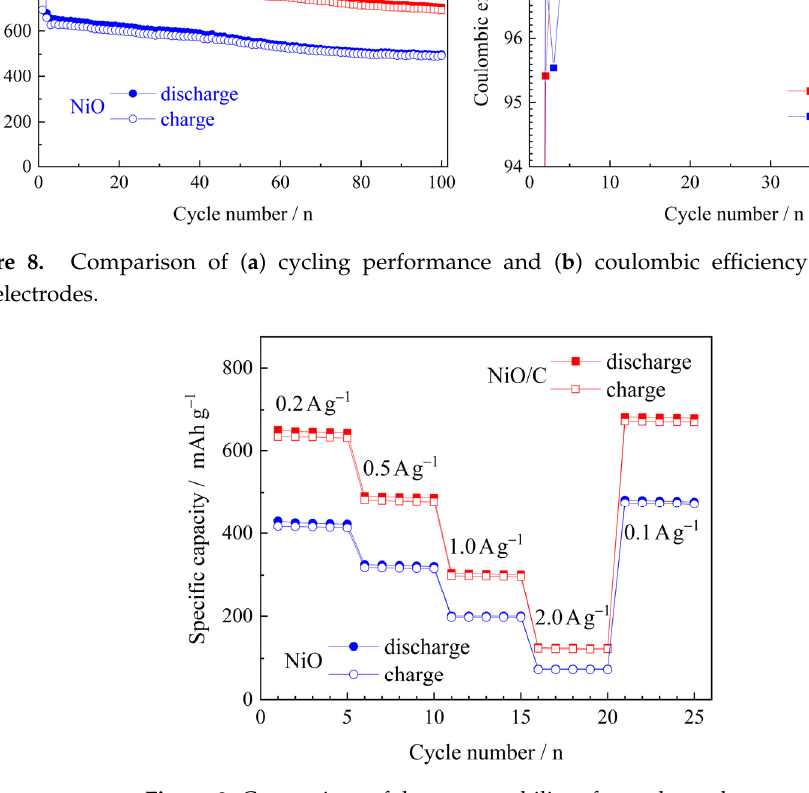
Figure 10. Comparison of the Nyquist plots of two electrodes.